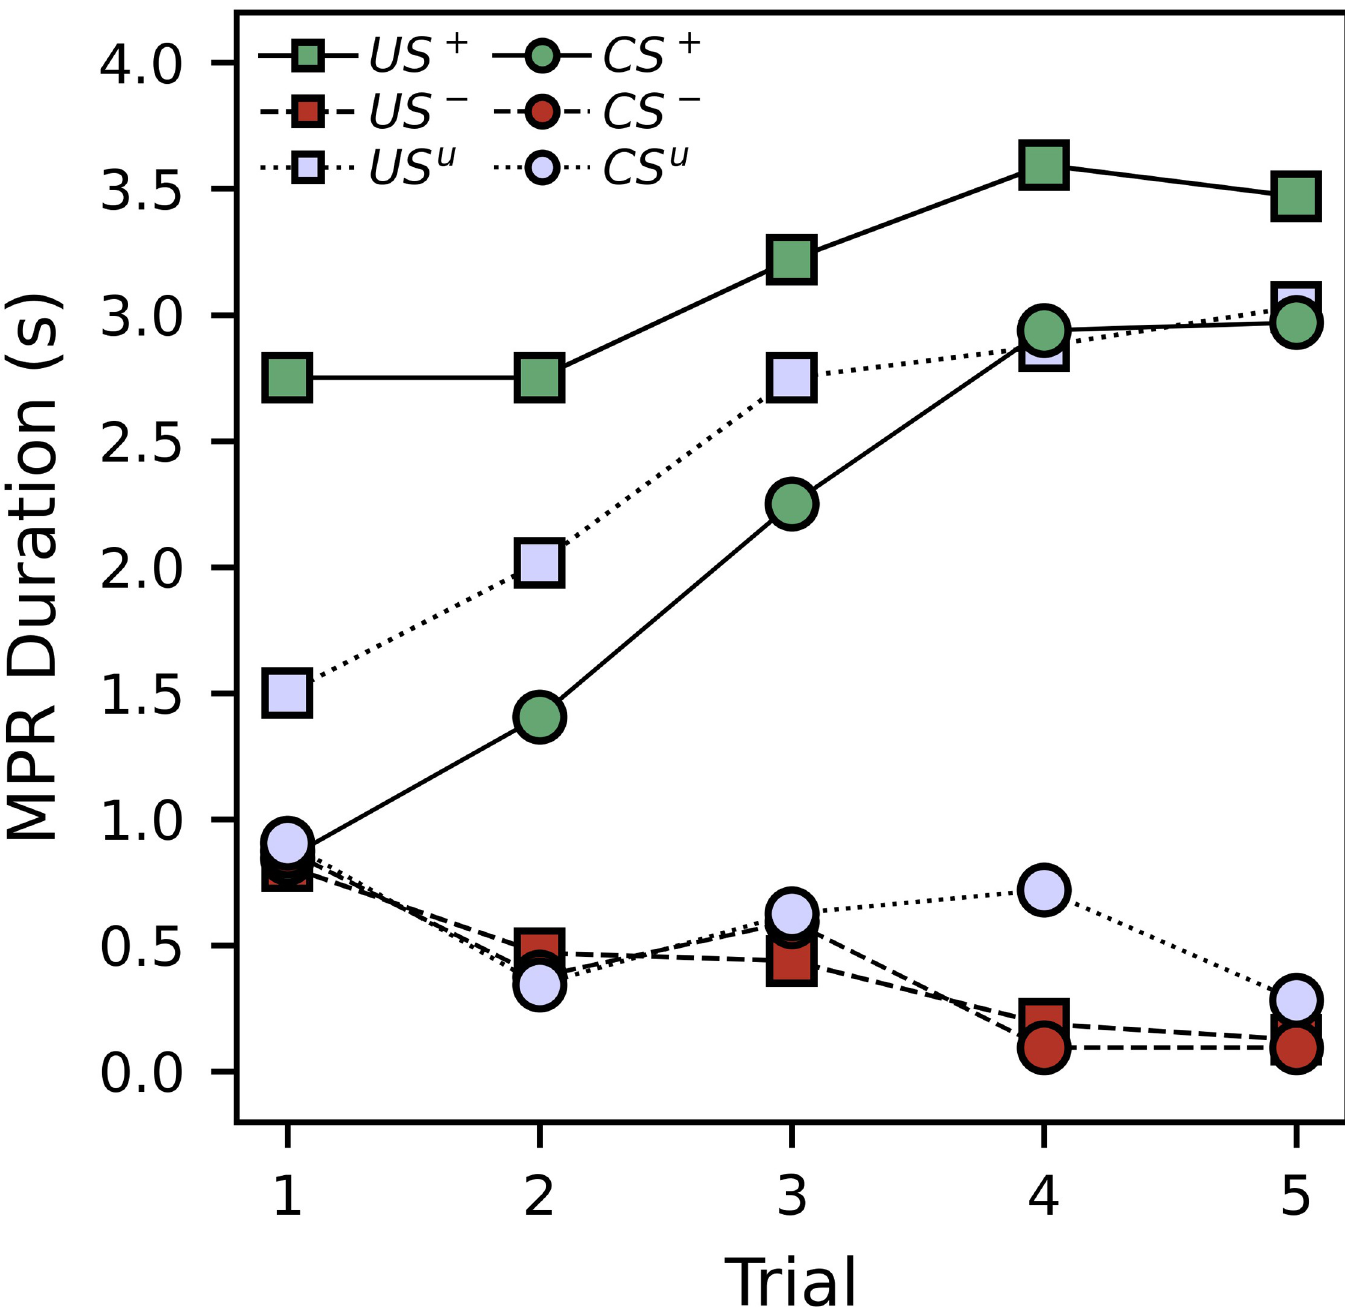
Fig 3. Experiment 1 average MPR duration in response to the US and CS for the paired and unpaired groups, divided trial type, during the conditioning